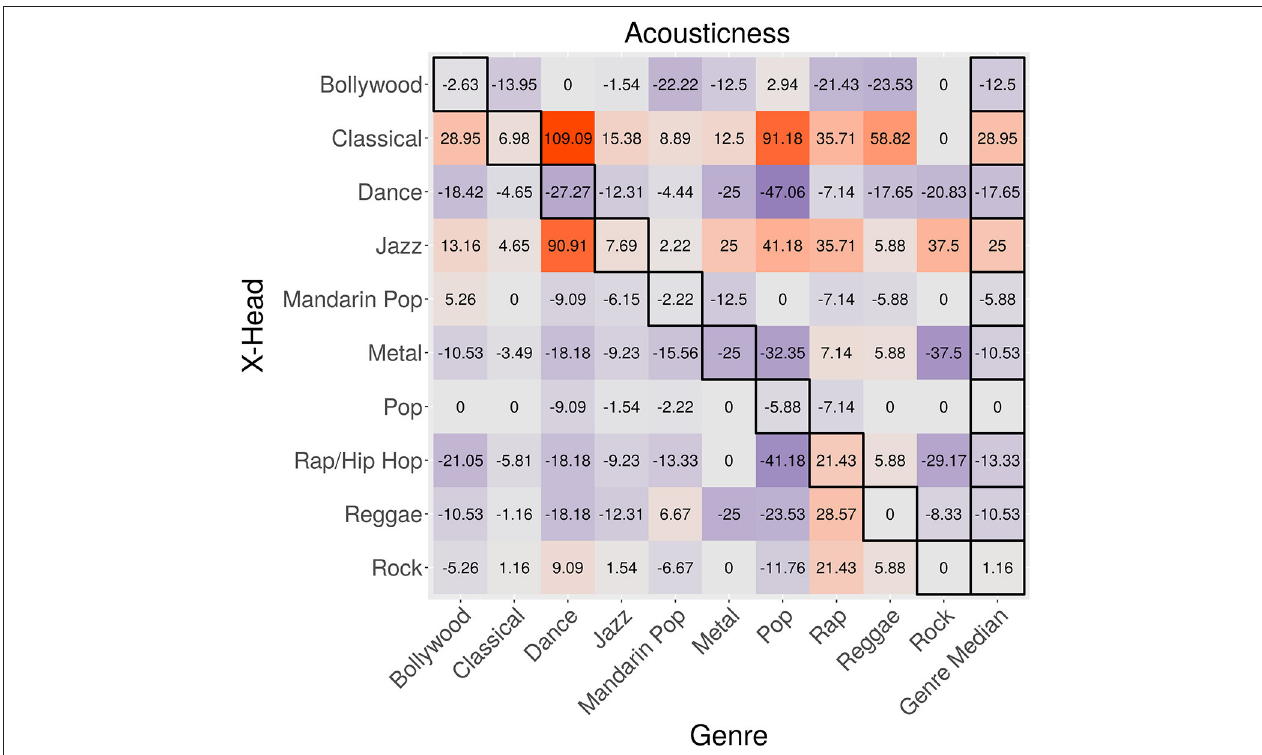
FIGURE 6 | Feature-influence matrix for Acousticness. The highlighted diagonal cells (running top-left to bottom right) show X-heads with respect to their main genres. The highlighted column on the right shows the median value of each row, excluding diagonally highlighted cells.